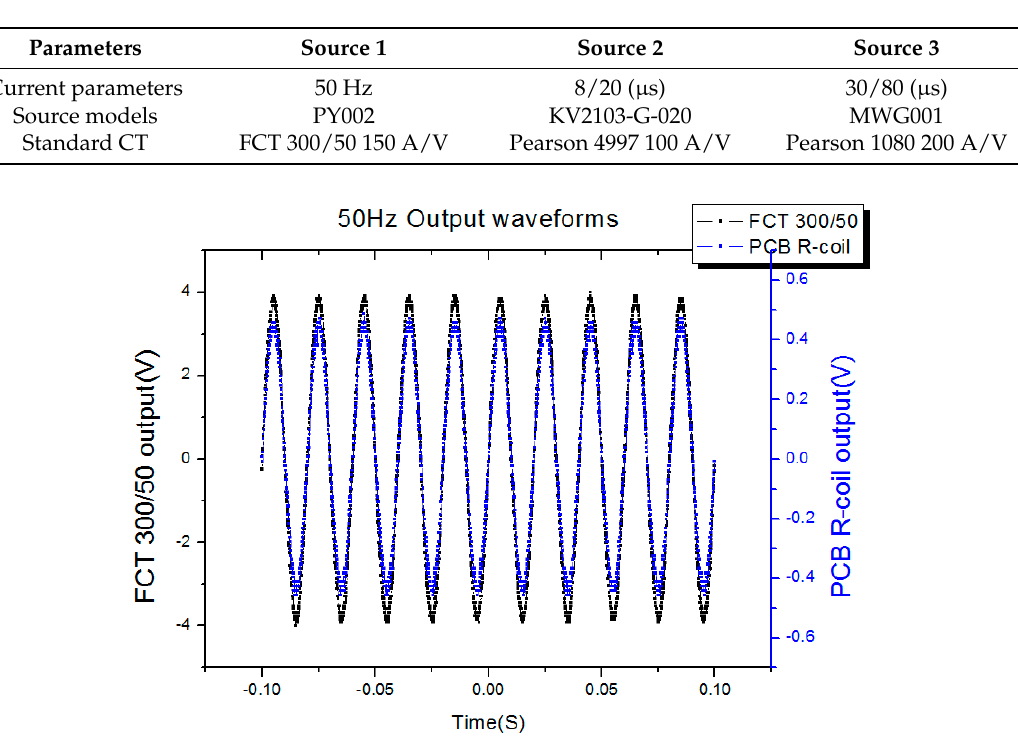
Figure 16. 8/20 impulse current output waveforms. Figure 17. 30/80 impulse current output waveforms.